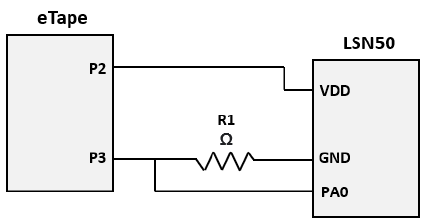
Figure 3. The voltage divider circuit of the proposed system.